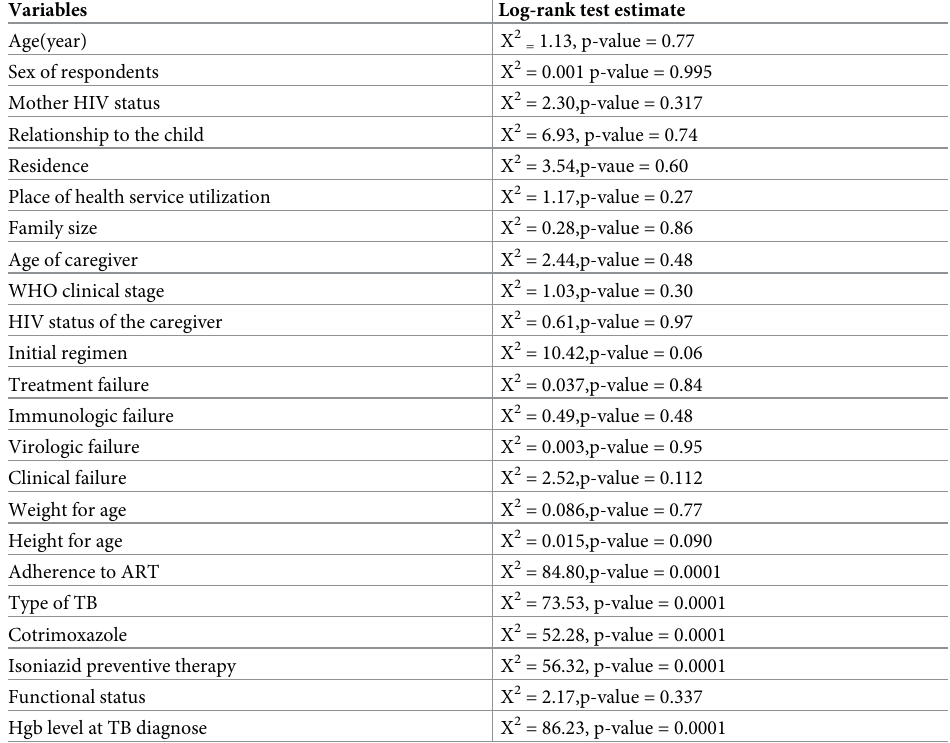
Table 5. Log rank estimate of variables among TB/HIV co-infected children at public hospitals in Southern Ethio- pia, 2020. Variables Log-rank test